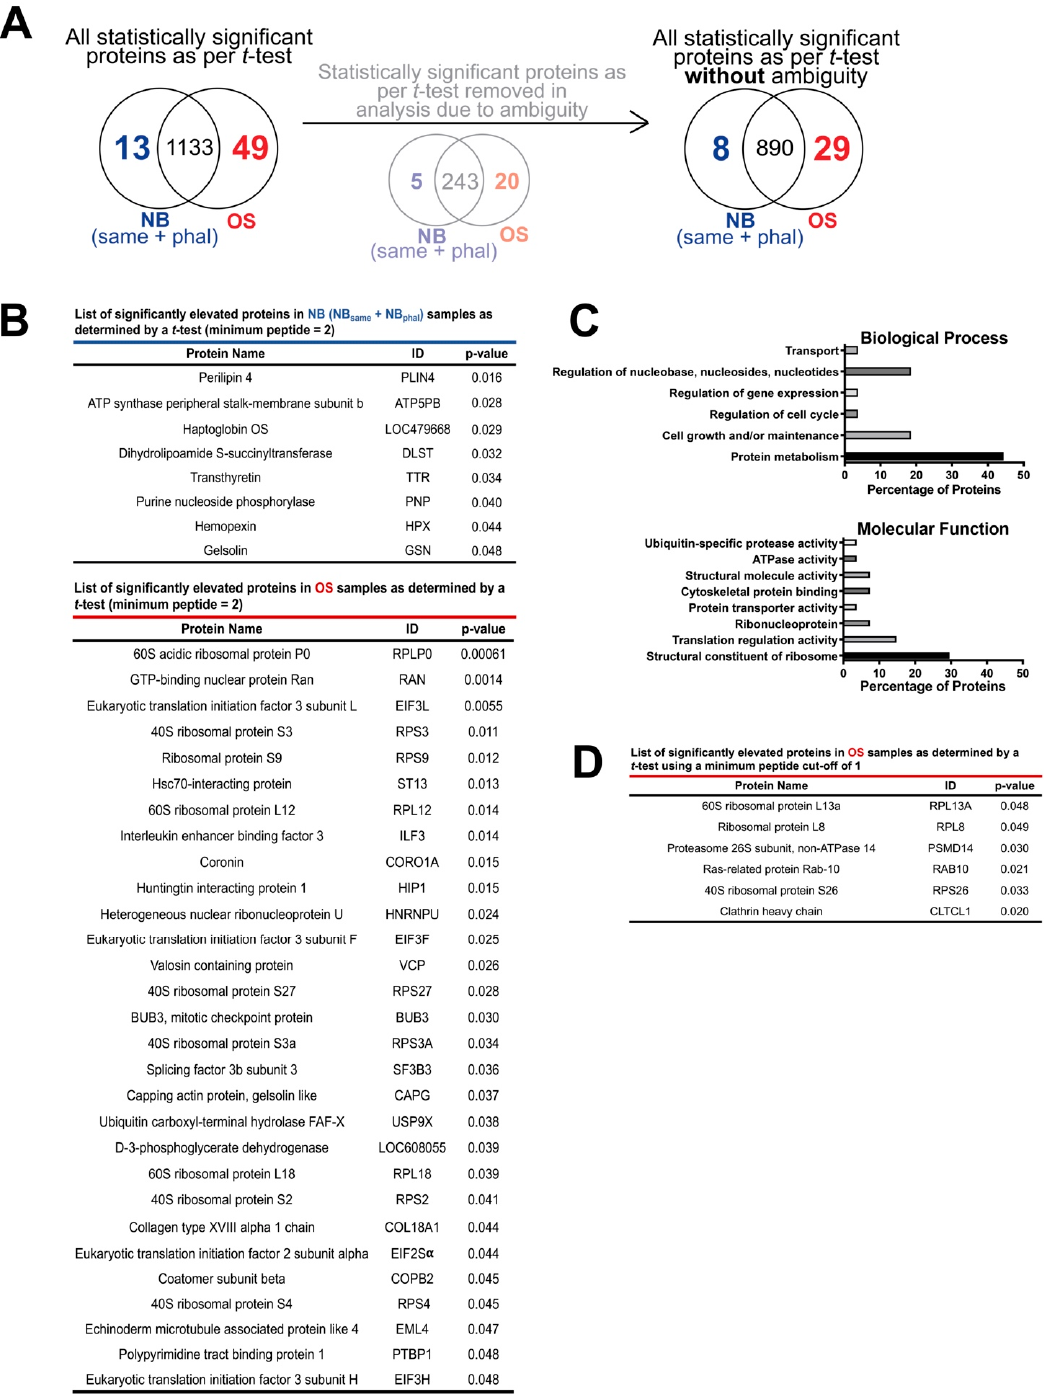
Figure 2. Proteins identified in UHPLC-MS/MS analysis including all samples. ( A ) Pie charts showing the number of statistically significantly proteins when comparing non-malignant bone (NB) and OS samples using a t -test. ( B ) Table of significantly elevated proteins found in the non-malignant bone samples (top) and OS samples (bottom) when using a minimum peptide = 2 as a cutoff and a t -test. ( C ) The molecular functions and biological processes of the significantly elevated proteins identified in the OS samples. ( D ) Table of significantly elevated proteins in OS samples when using a minimum peptide = 1 as a cutoff and a t